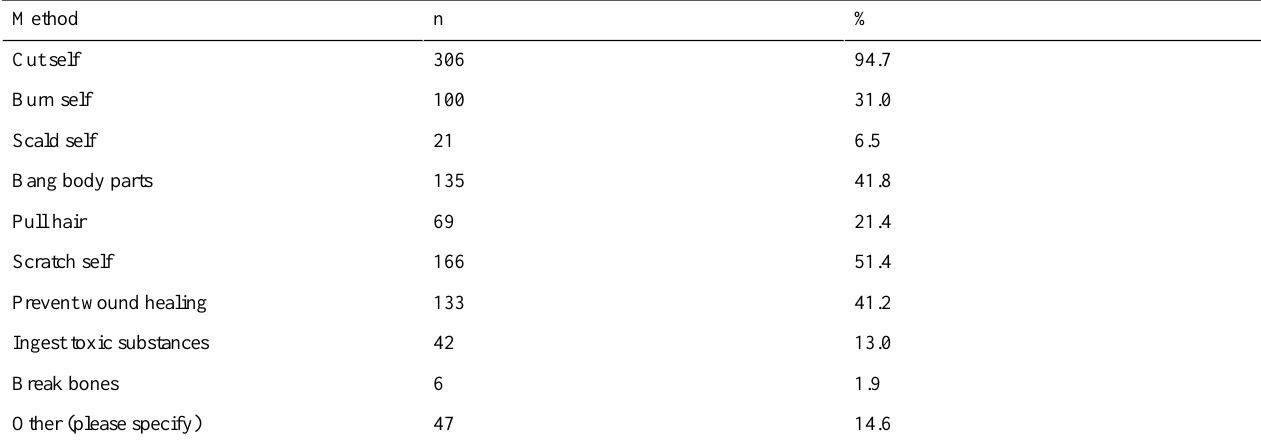
Table 1. Methods of self-harm used by participants a